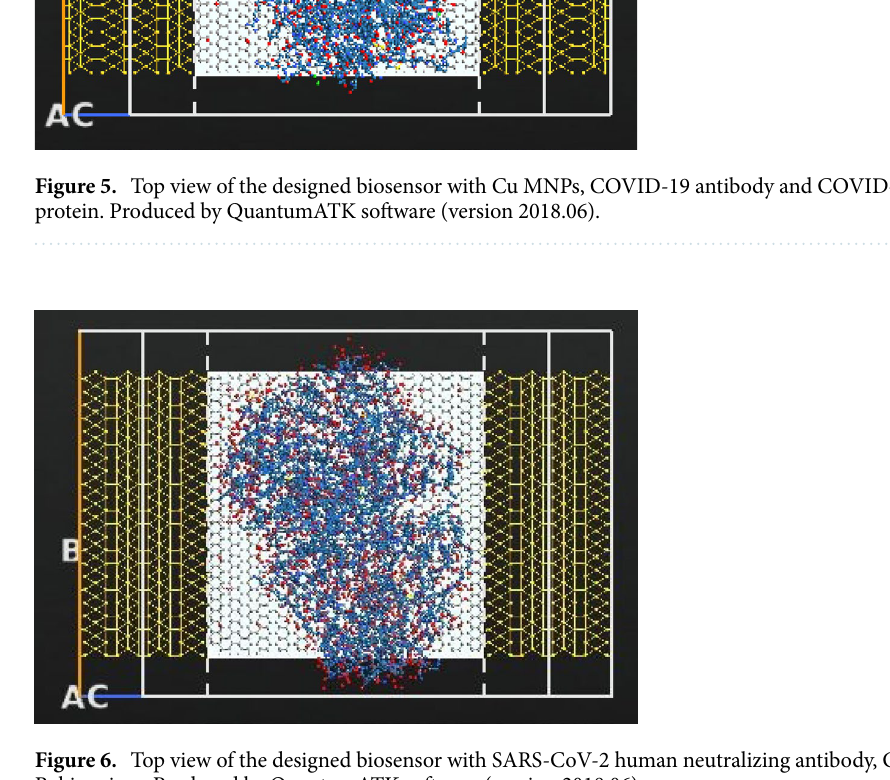
Figure 6. Top view of the designed biosensor with SARS-CoV-2 human neutralizing antibody, Cu MNPs and Rabies virus. Produced by QuantumATK software (version 2018.06).